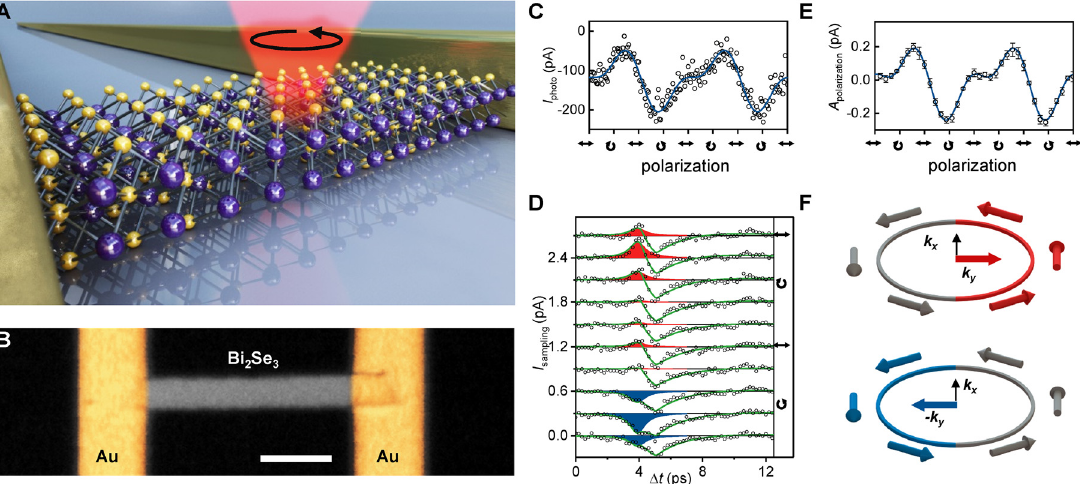
Figure 4: Helicity-control of ultrafast currents in topological insulators. (A) Helical excitation controls surface currents in topological insulators. (B) Optical microscope image of a Bi 2 Se 3 thin- fi lm embedded into a THz-stripline circuit. Scale bar, 5 µm. (C) Time-averaged photocurrent I photo versus photon polarization. (D) Time-resolved photocurrent I sampling at the center of the Bi 2 Se 3 - fi lm for varying laser polarization. Solid lines are fi ts to the data, blue and red areas display the polarization-controlled ultrafast currents. Data are equidistantly displacedforclarity.(E)Fittedamplitudeof I sampling foratimedelayof Δ t =4psversusphotonpolarization.(F)Schematicofthephotogalvanic current in the direction of k y to the right contact (red) or − k y to the left contact (blue) with an in-plane spin polarization. Reproduced